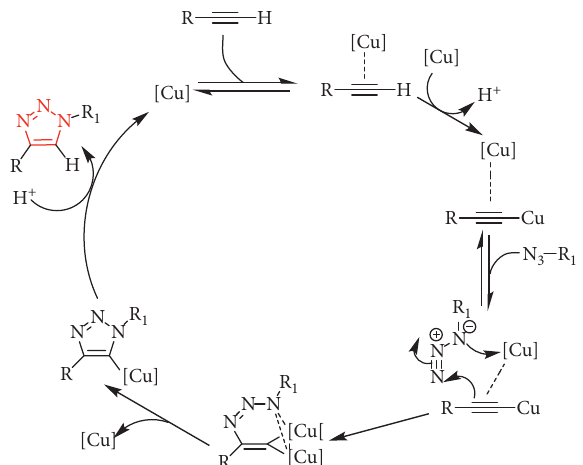
Scheme 6: Mechanism of the copper-catalyzed azide-alkyne cy- cloaddition (CuAAC).